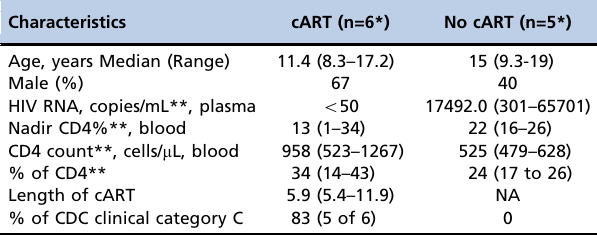
Table 1 - Baseline characteristics of the patients with human immunodeficiency virus (HIV) infection (HI) patients, either receiving or not receiving the combined antiretroviral therapy